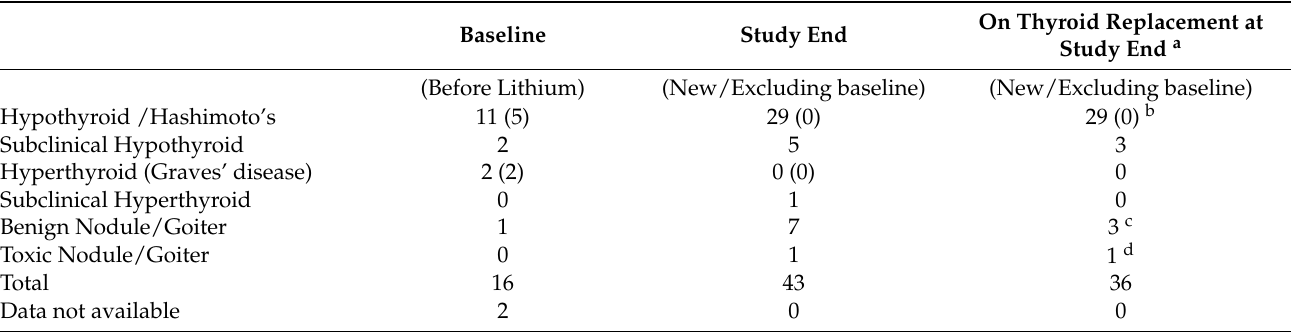
Table 2. Thyroid status of patients with abnormal thyroid functioning.